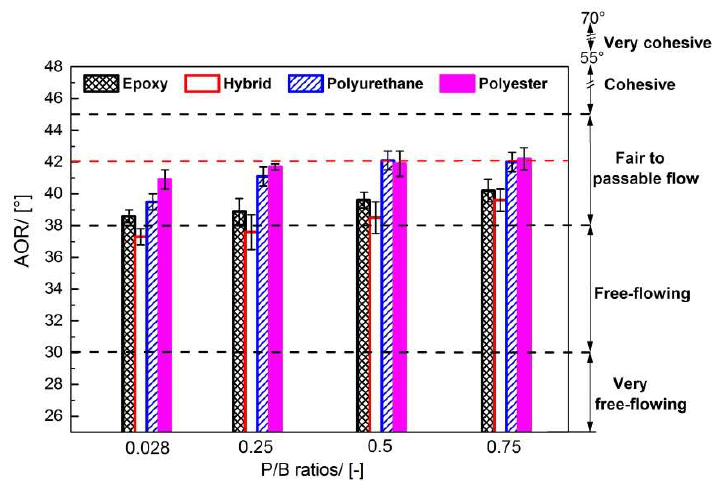
Figure 1. Angle of repose values ( AORs) of paint powders with different resins and pigment to binder ratios (P/Bs).